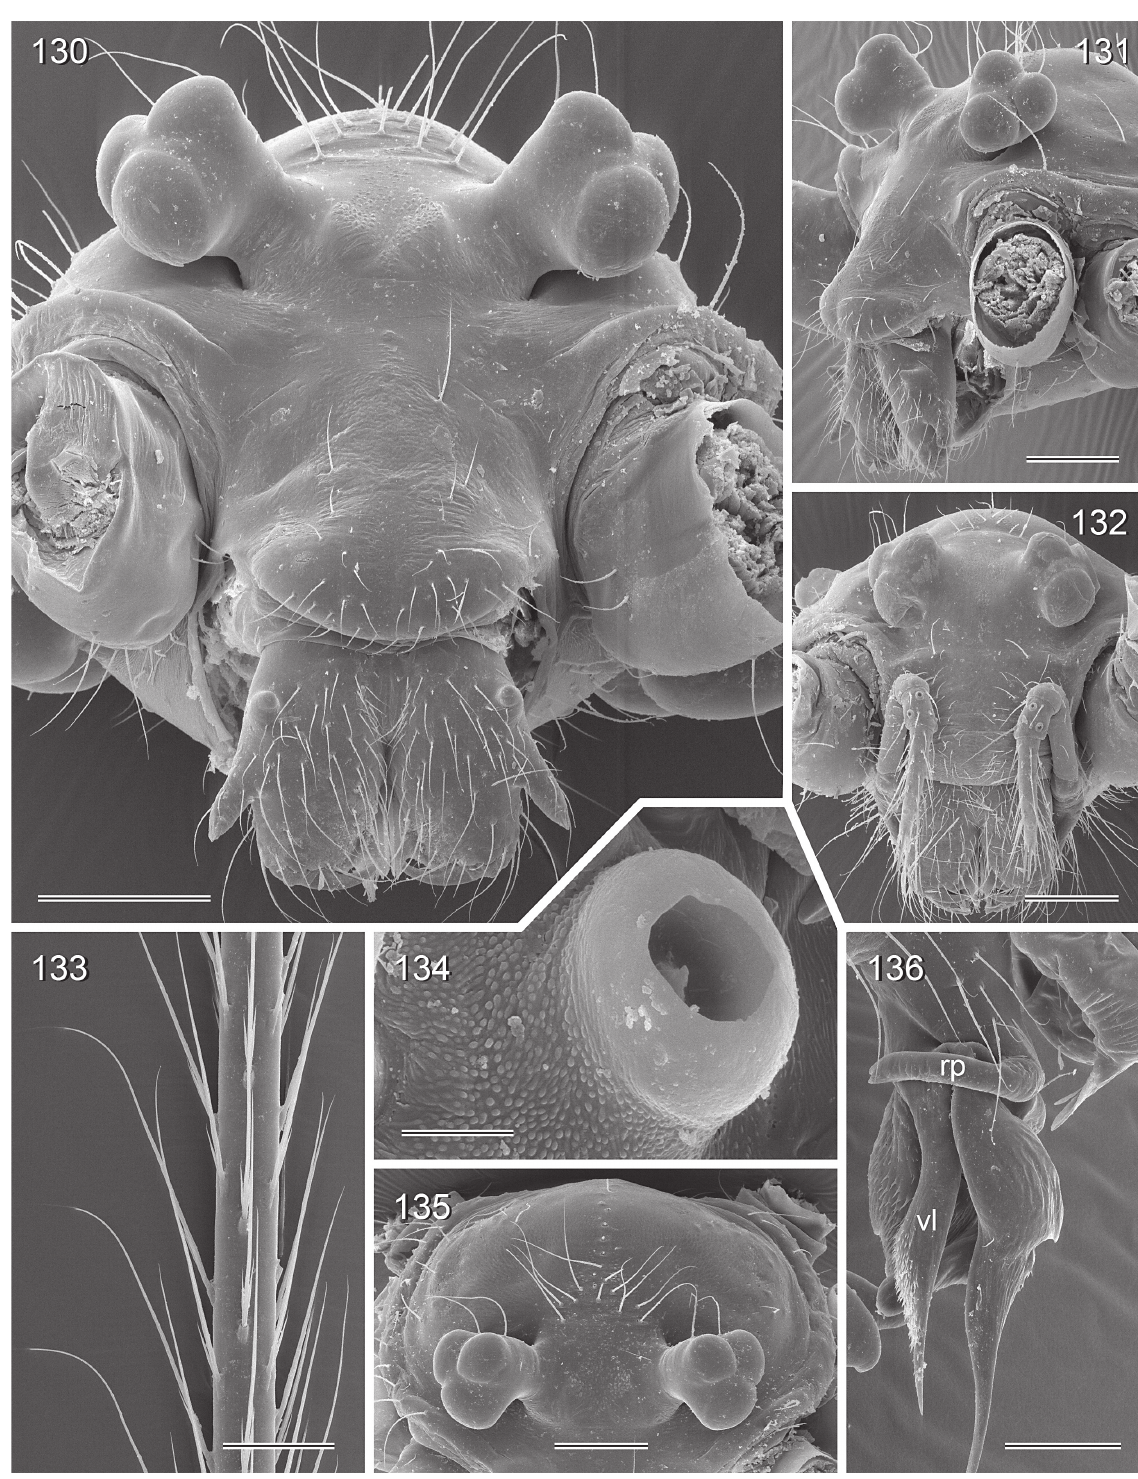
Figs 130–136. Aetana gaya Huber, sp. nov. 130–131 . Male prosoma, frontal and oblique frontal views. 132 . Female prosoma, frontal view. 133 . Detail of male metatarsus 1. 134 . Male palpal tarsal organ. 135 . Male carapace and ocular area. 136 . Right procursus, retrolateral view. rp = retrolatero-ventral process; vl = ventral lamina. Scale lines: 130–132, 135 = 200 µm; 133 = 80 µm; 134 = 8 µm; 136 = 100